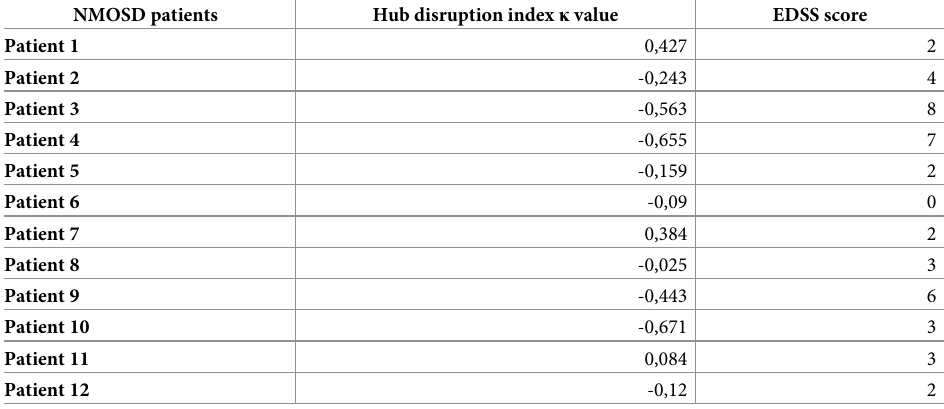
Table 2. The hub disruption index κ and EDSS score for each NMOSD